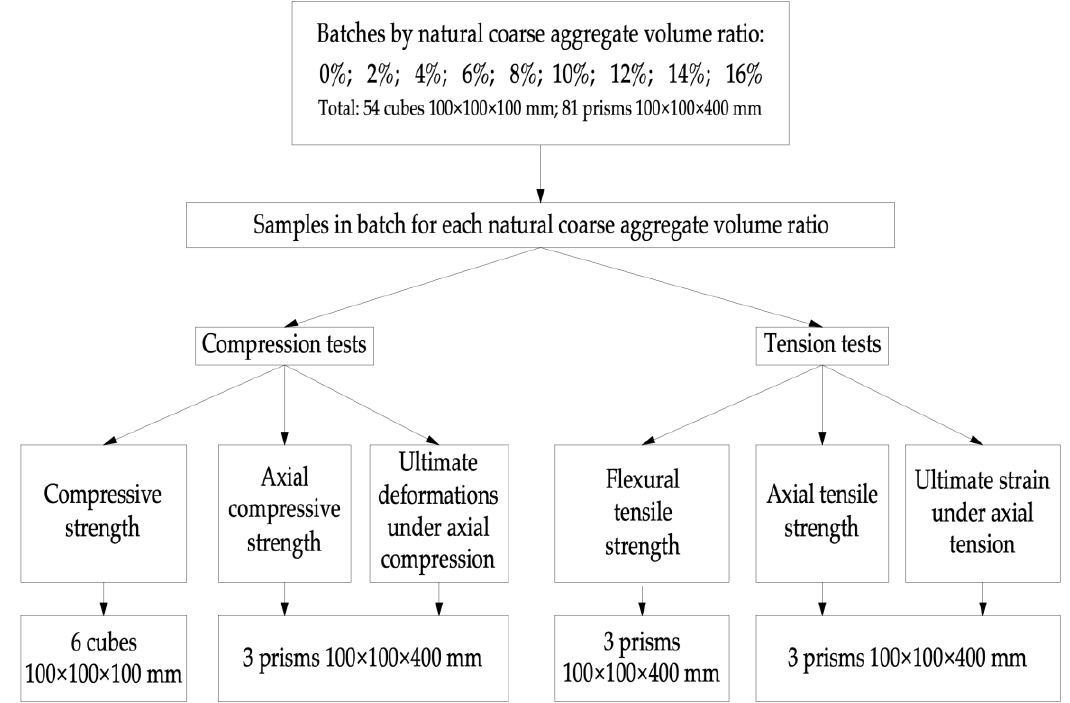
Figure 3. The program of investigations of the influence of local replacement of CA with RT seed shells on the strength – strain features of concrete.